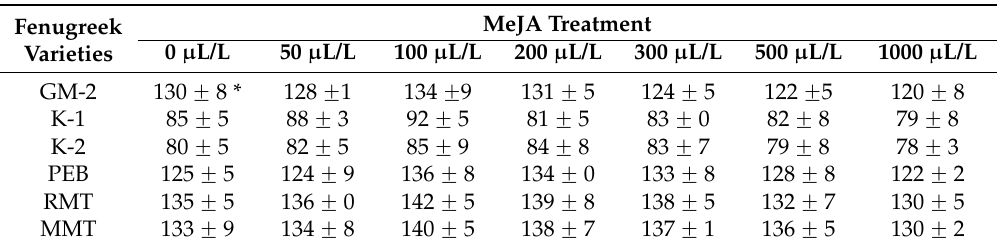
Table 5. Effect of methyl jasmonate (MeJA) treatments on the dry weight (mg) of seedlings of different fenugreek ( Trigonella foeum-graecum L.)